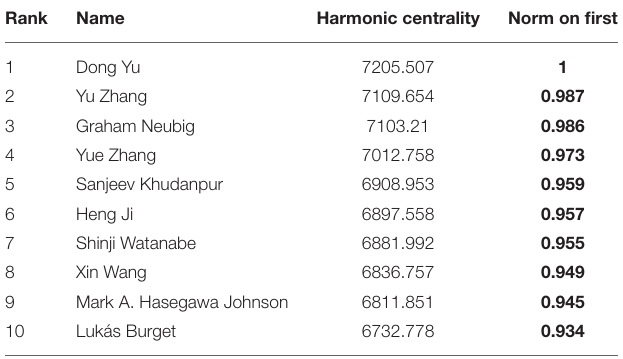
TABLE 11 | Betweenness centrality for the 10 most central authors in the past 5 years